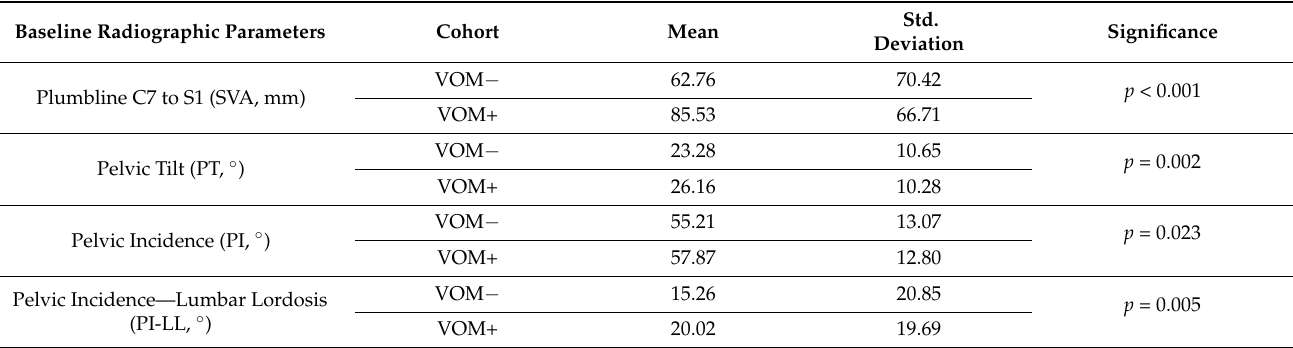
Table 2. Baseline radiographic comparison of C7-S1 plumbline (SVA), pelvic tilt (PT), pelvic incidence (PI), and pelvic incidence minus lumbar lordosis (PI-LL) of VOM+ and VOM −